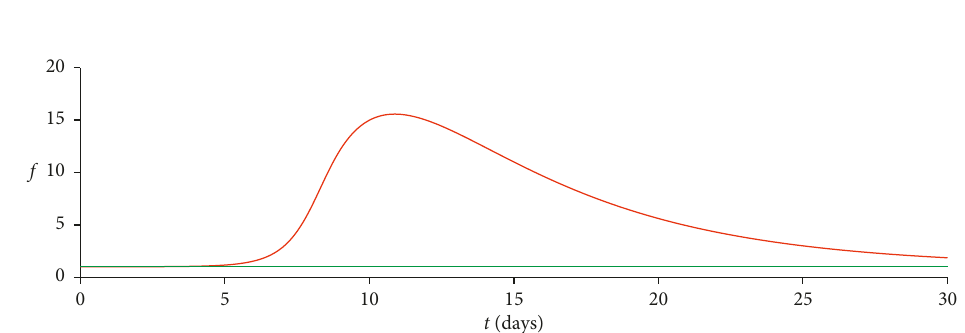
Figure 3: Dynamics of the immune response: antibodies.